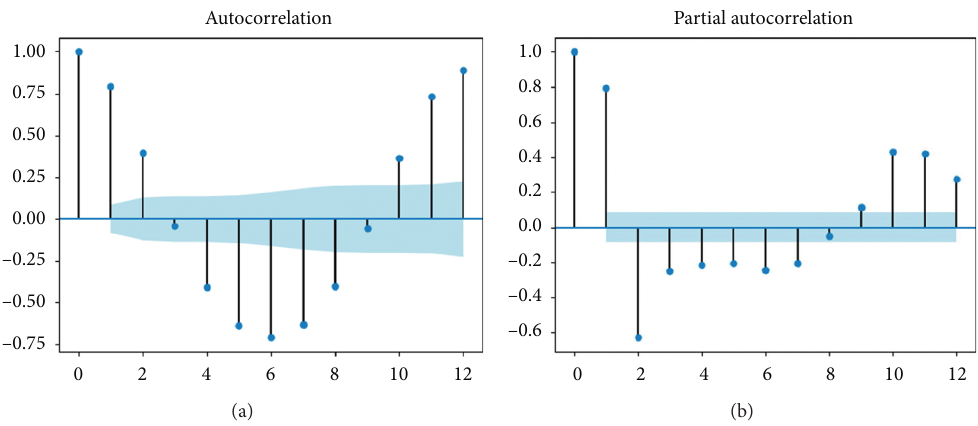
Figure 7: Correlation analysis for streamflow. (a) Autocorrelation function. (b) Partial autocorrelation function.